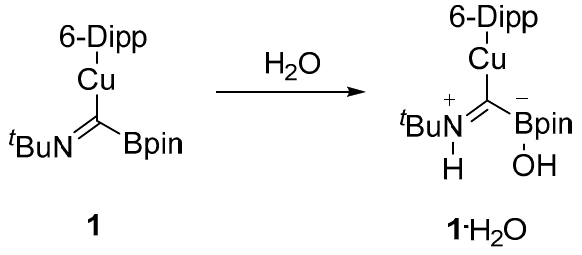
Scheme 2. The reaction between compound 1 and water to yield 1 · H 2